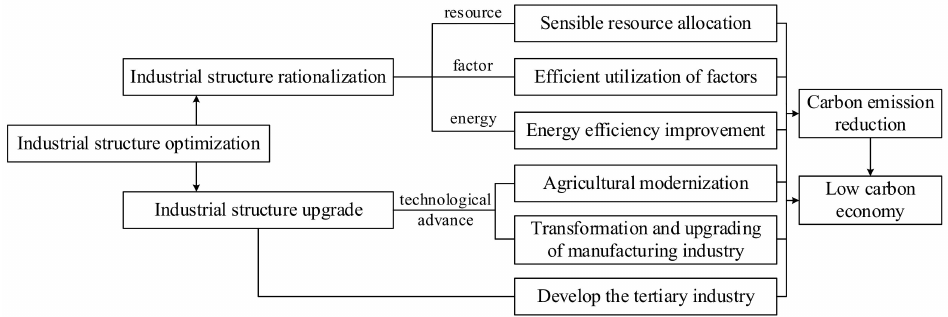
Figure 2. Influence path of industrial structure optimization on carbon emission